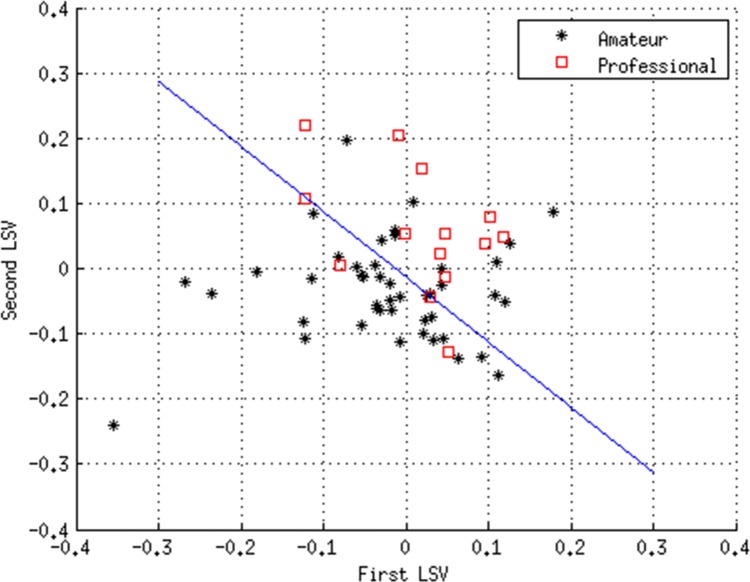
Cut-off demarcation line (blue line) necessary to achieve optimum separation of the amateur and professional sub-groups in the exploratory dataset.